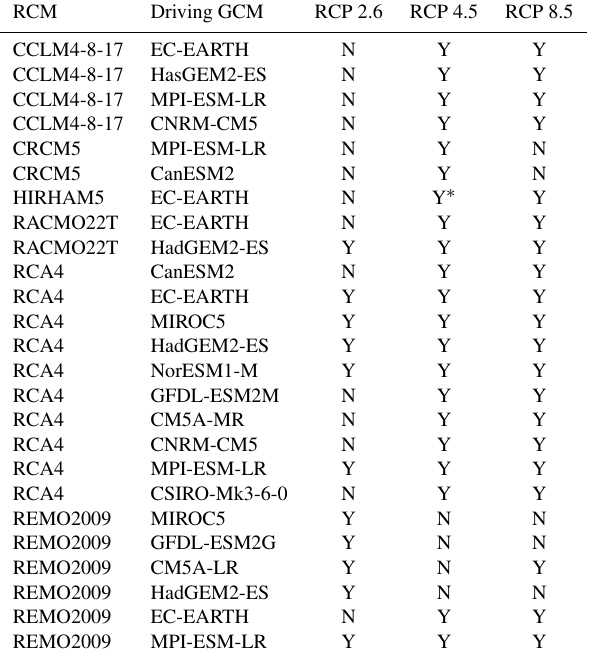
Table A1. Overview of the different CORDEX simulations and their availability (Y: yes, N: no). ( ∗ data not used because of dis- crepancy between historical and future simulation).